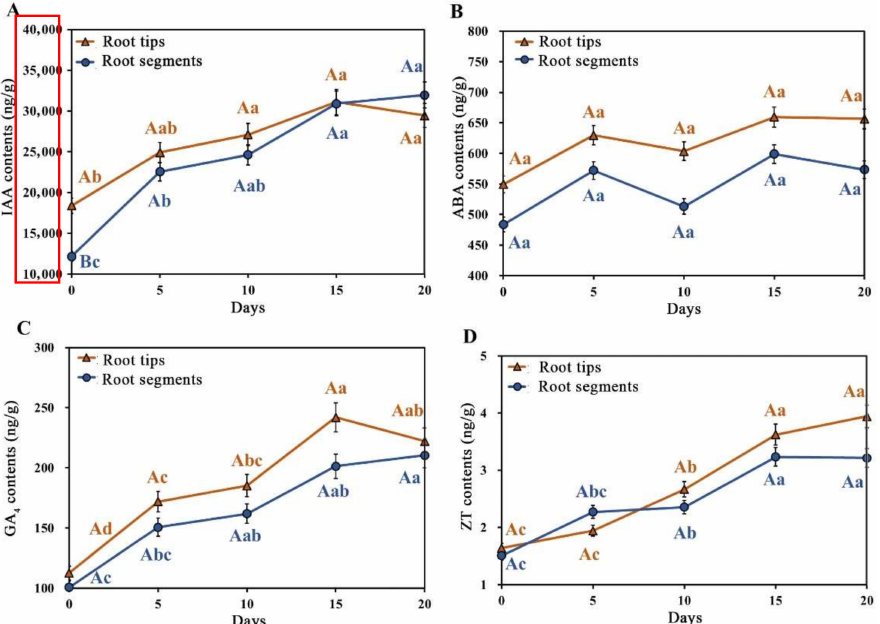
Figure 3. The dynamic changes of endogenous hormones in the root tips and segments of A. praecox during callus induction. ( A ) IAA; ( B ) ABA; ( C ) GA 4 ; ( D ) ZT. The different letters indicate significant differences at 5% level by Duncan’s range test.